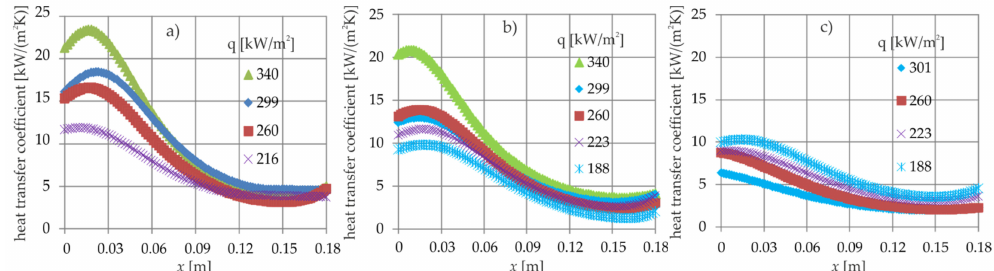
Figure 13. Heat transfer coe ffi cient as a function of minichannel length ( a ) for G = 8.6 kg / (m 2 s), ( b ) G = 5.9 kg / (m 2 s) and ( c ) G = 2.2 kg / (m 2